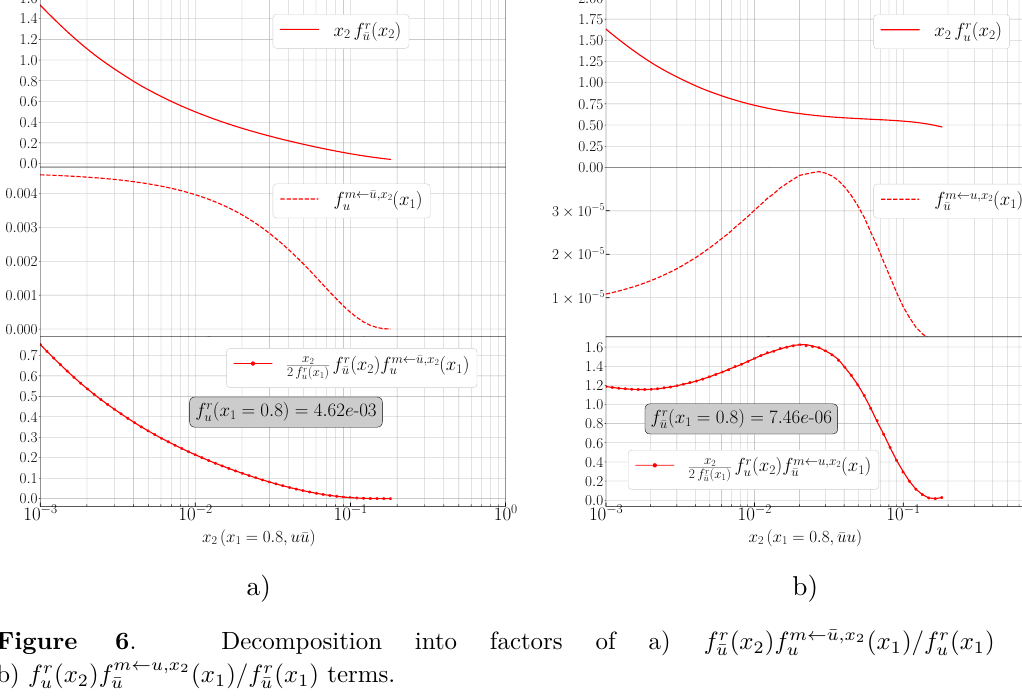
Figure 6 . Decomposition into factors of a) f r b) f r ( x 2 ) f m ← u,x 2 u ¯ u